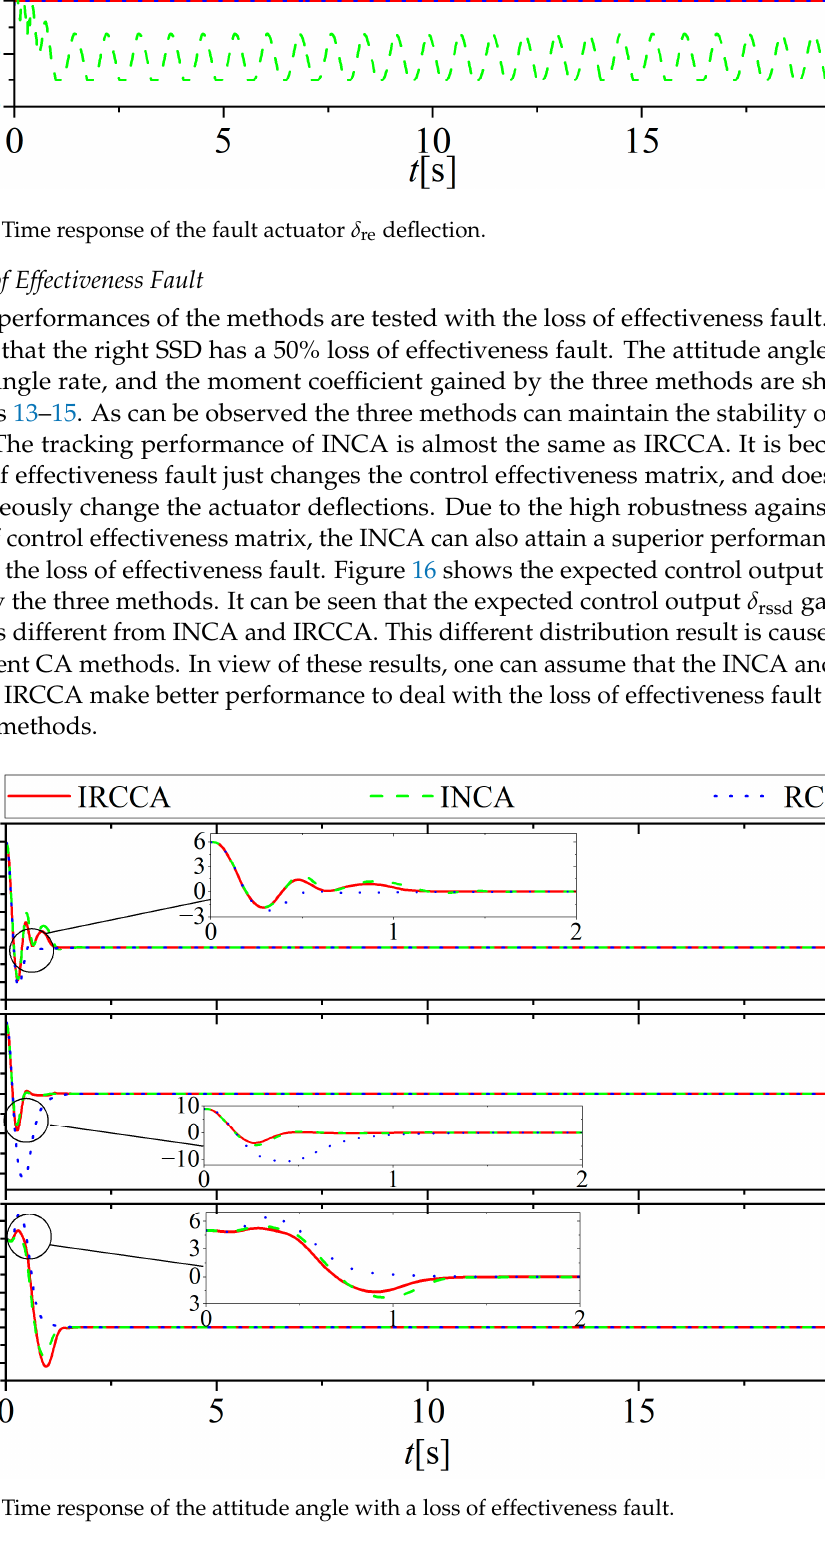
Figure 14. Time response of the attitude angle rate with a loss of effectiveness fault.